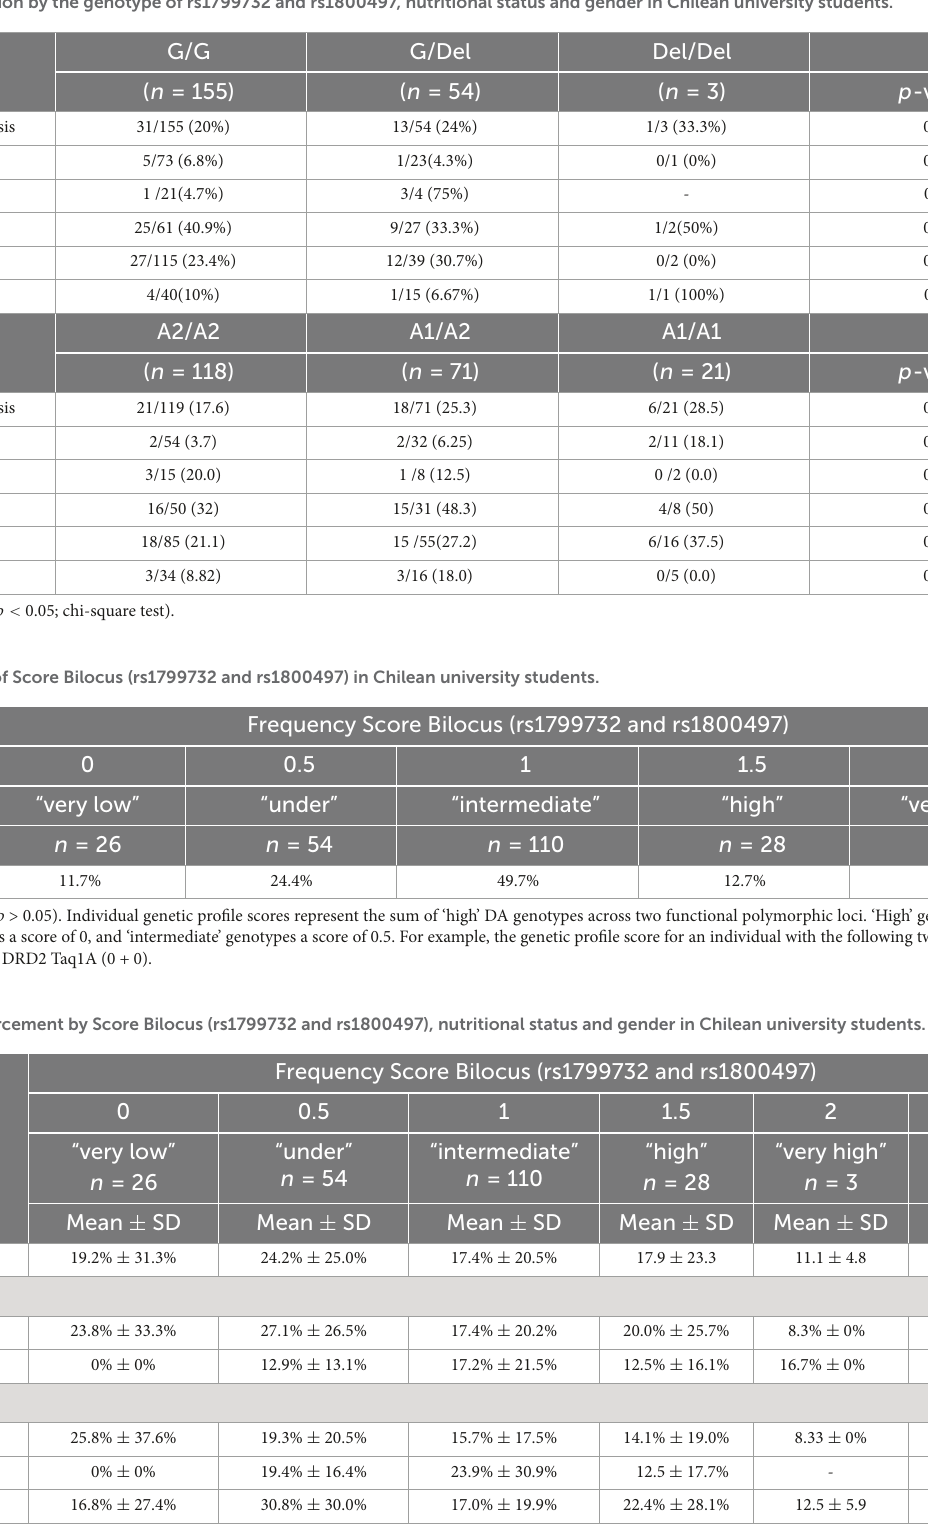
TABLE 3 Food addiction by the genotype of rs1799732 and rs1800497, nutritional status and gender in Chilean university students.